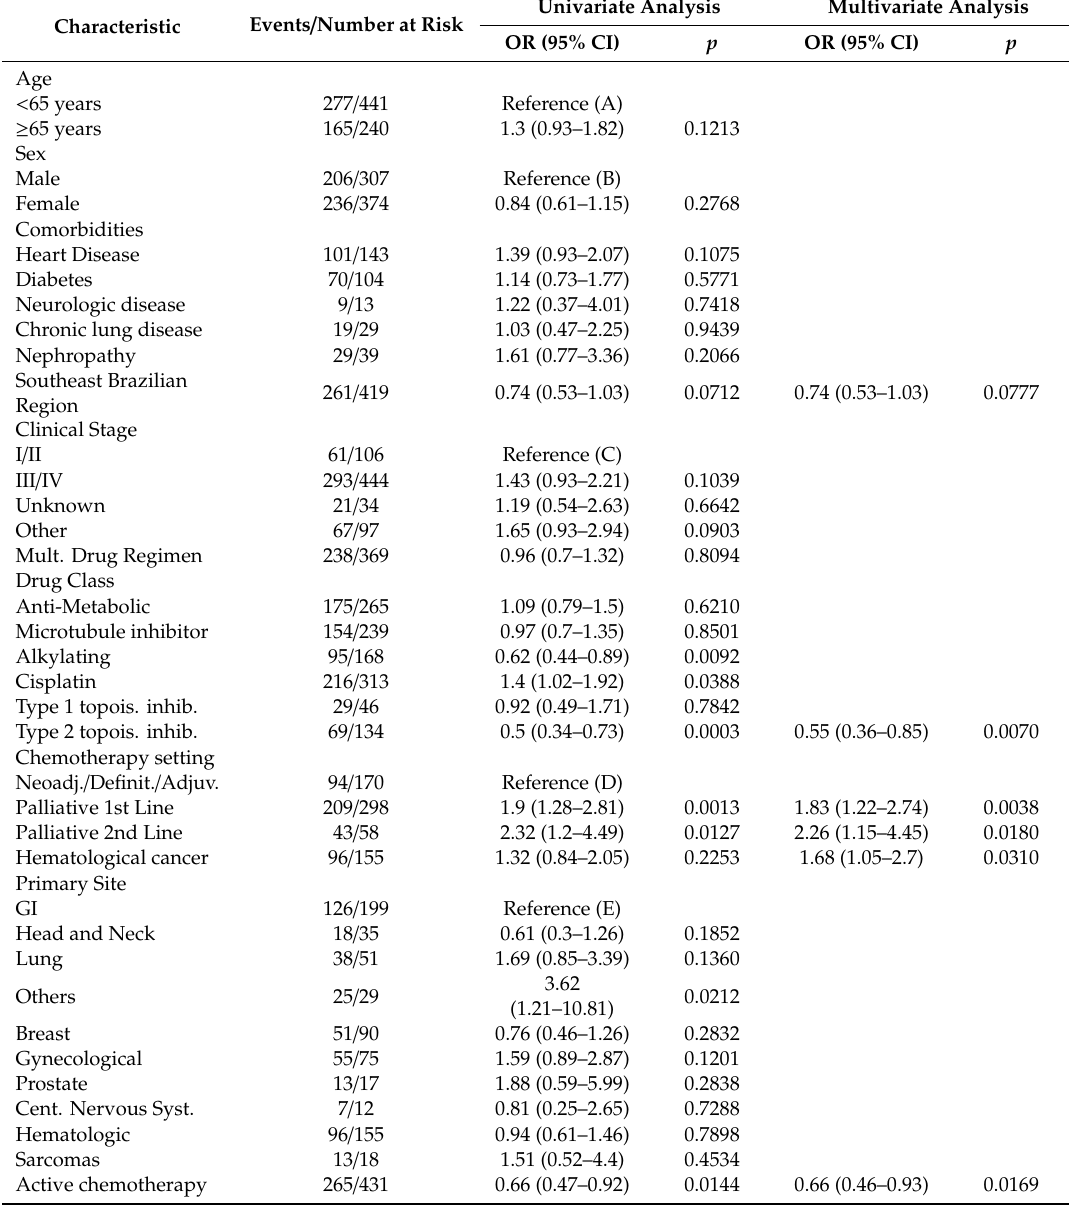
Table 2. Univariate and multivariate analysis of risk to death in COVID-19